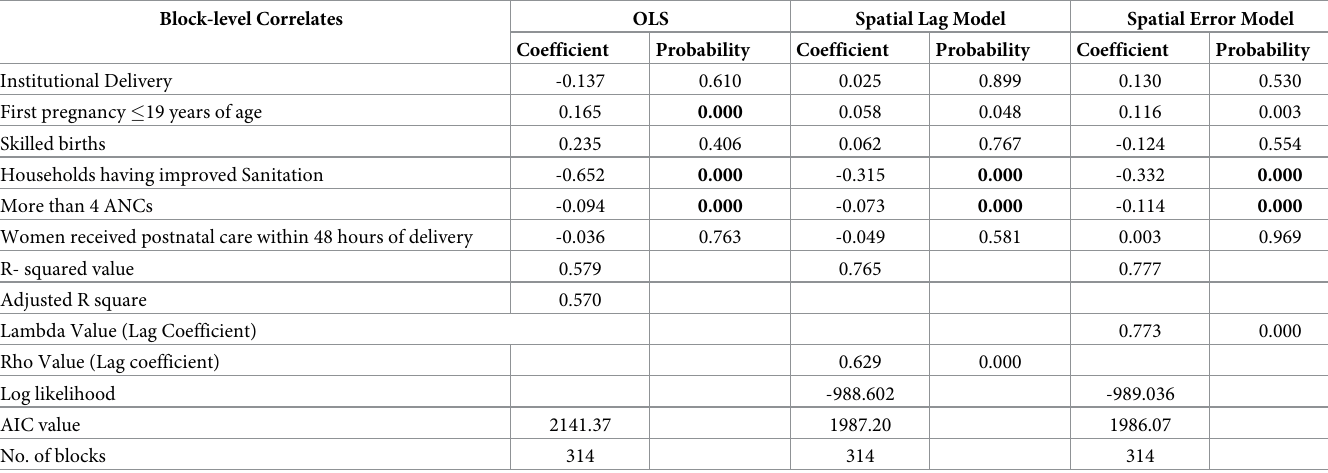
Table 4. Results- spatial regression models: OLS, spatial lag & spatial error model, block-wise, CCM-II, 2014–15, Odisha, India. Block-level